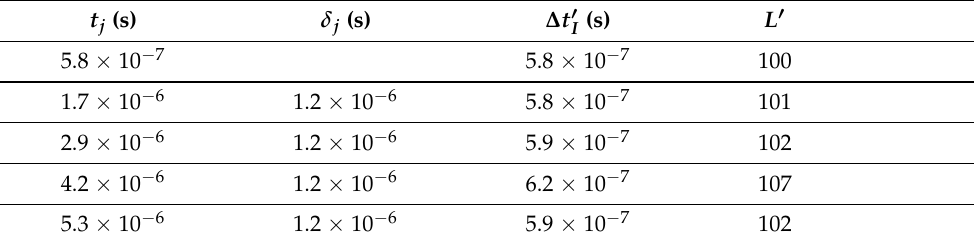
Table 2. Distance calculations from the simulation results.